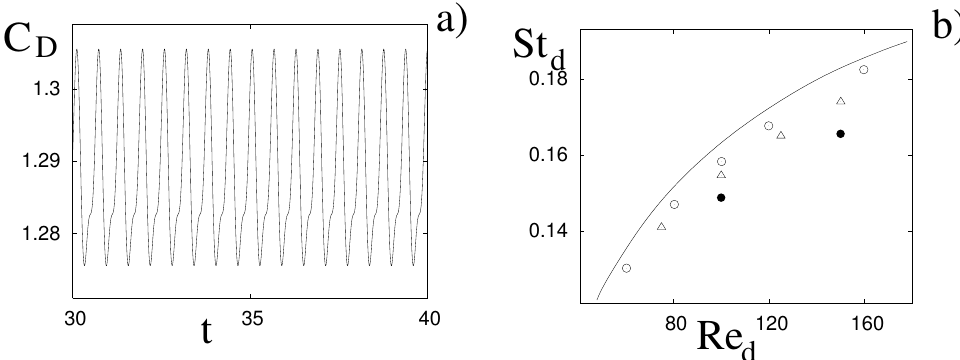
Figure 11. ( a ) Time evolution of the drag coefficient for the flow at Γ = 0.1 and Re = 1000 ( Re d = 100); ( b ) Strohual number ( St d ) versus Reynolds number ( Re d ): data for the circular cylinder (from [2]) ◦ flow around a torus at Γ = 0.1, (cid:52) flow around a torus at Γ = 0.25, • flow around a torus at Γ =